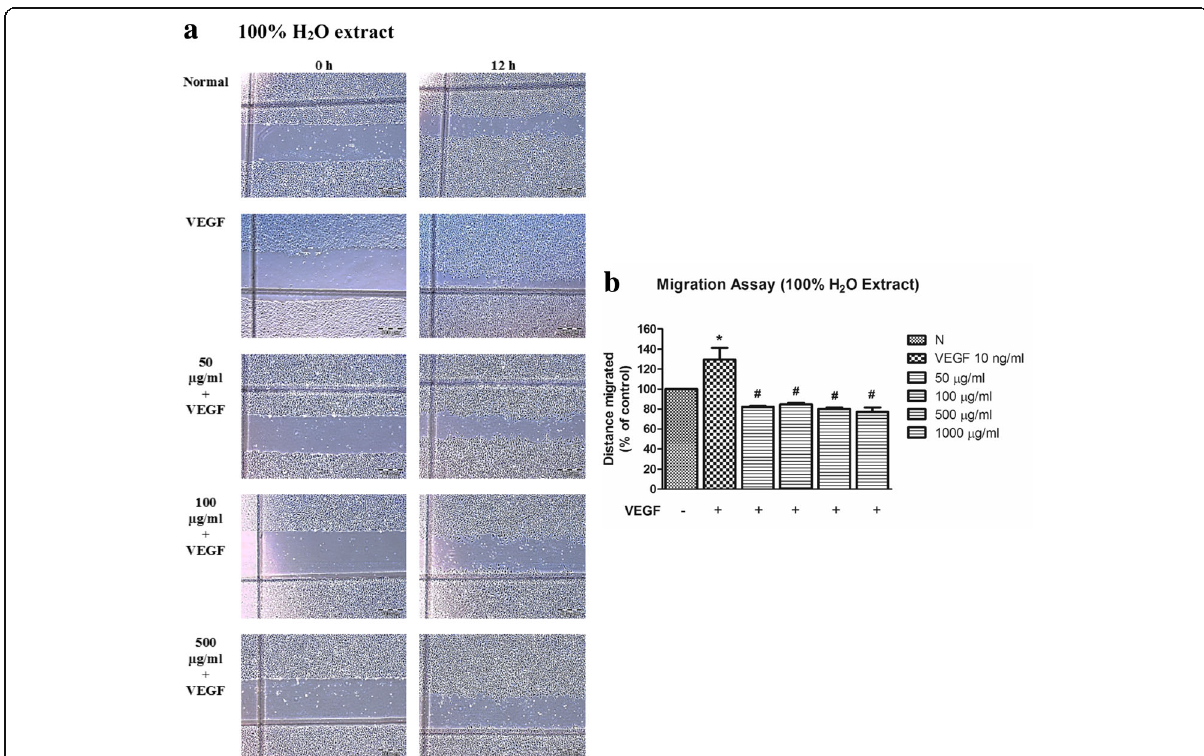
Fig. 4 Effect of C. nutans water extract on VEGF-induced cell migration. a Anti-migratory effect of 100% water extract of C. nutans leaves. Representative width were photographed. b HUVECs treated with water extract of C. nutans leaves showed reduction in migration rate. The values presented are the mean±SEM of three independent experiments. * p <0.05 were considered significant when compared to normal control (N); # p <0.05 were